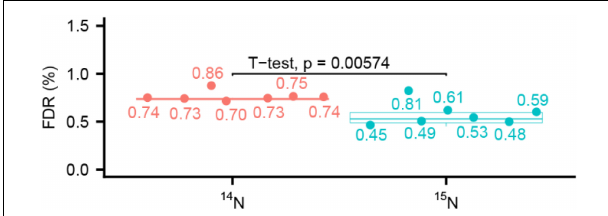
FIGURE 4 | Comparison of false discovery rate (FDR) at peptide level between 14 N search and 15 N search shows 15 N has a lower FDR. 14 N and 15 N searches are reported together allowing 1% FDR for peptides, then the target and decoy matches are parsed to calculate the FDR for 14 N search and 15 N search. Seven datasets ( n = 7) are used for the